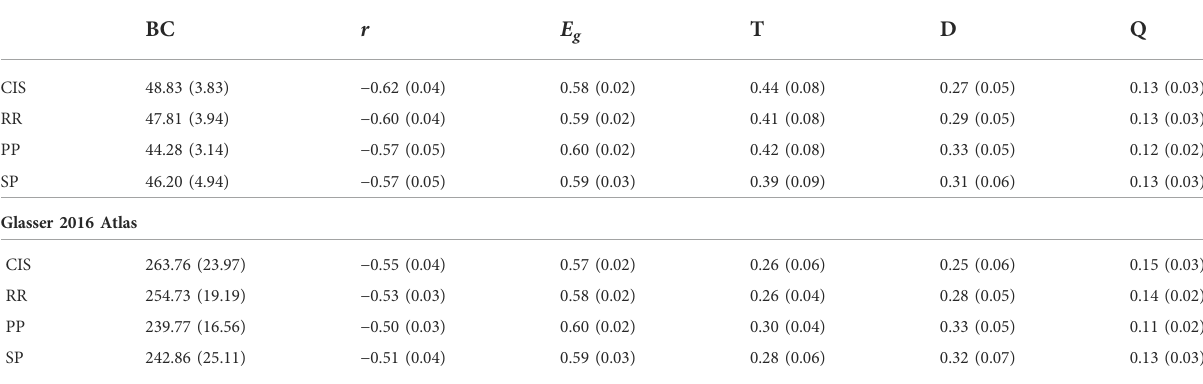
TABLE 9 Mean (st.dev) values of global metrics [Betweenness Centrality ( BC ), Assortativity ( r ), Transitivity (T), Ef fi ciency ( E g ), Modularity (Q) and Density ( D )] were calculated on binarized graphs for τ =0.7 using FSAverage and Glasser 2016 atlas. FSAverage